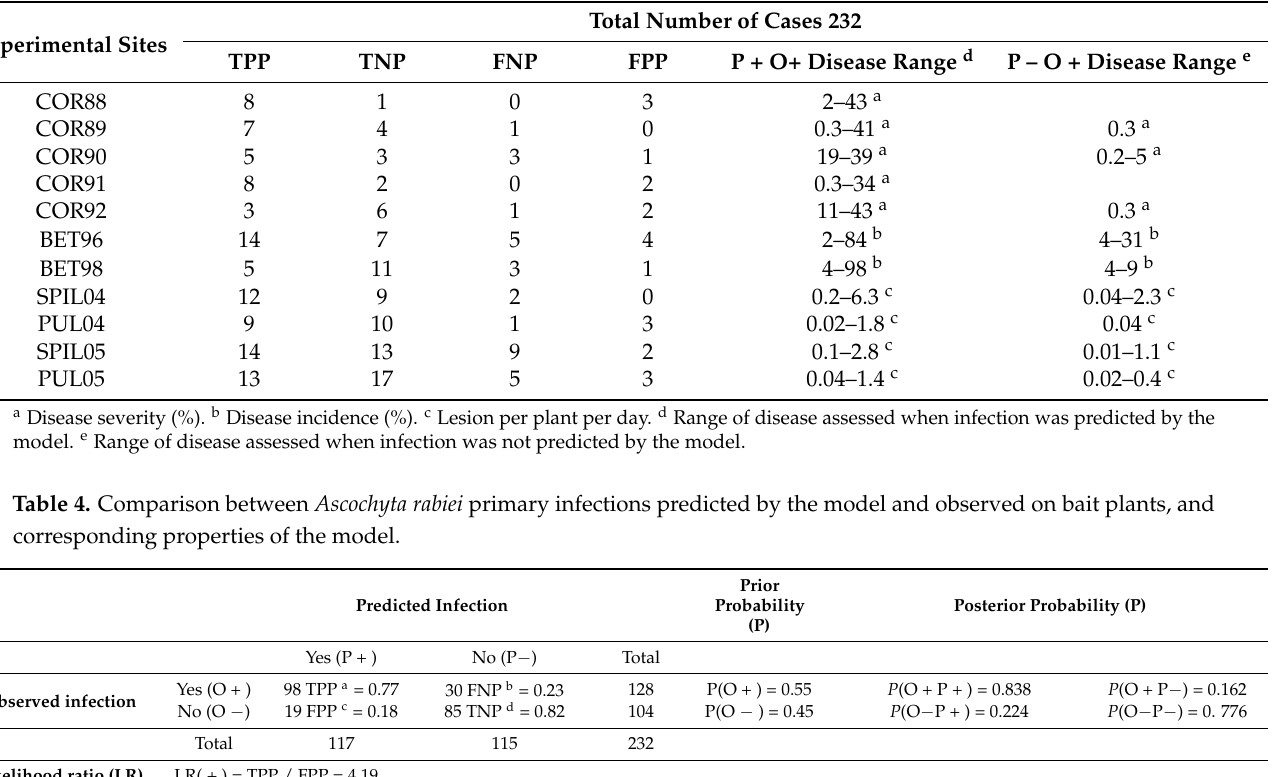
Table 3. Experimental sites (acronyms for locations and years) used to validate model predictions of primary infection. Periods of bait plant exposure were classified as follows: TPP = true positive proportion (sensitivity), TNP = true negative proportion (specificity), FNP = false negative proportion, and FPP = false positive proportion.